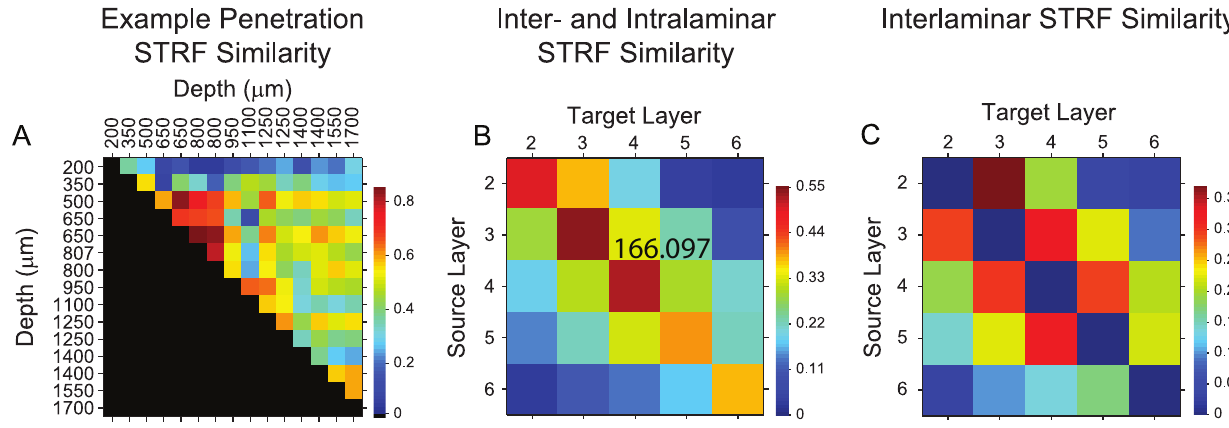
Figure 9. STRF similarity for functionally connected neurons. (A) Example STRF similarity index matrix for the neurons in Fig. 1. Each matrix element represents the similarity between the STRFs of different neurons. The similarity between STRFs is greatest between neurons at supragranular (200–800 m m) and granular (800–1100 m m) layer depths. Data below the diagonal are not shown since the matrix is symmetric. (B) Intra- and interlaminar STRF similarity across all data, grouped according to layer. STRFs are most similar for connected neurons within the same layer. (C) Interlaminar STRF similarity data (data from (B) with intralaminar data removed).